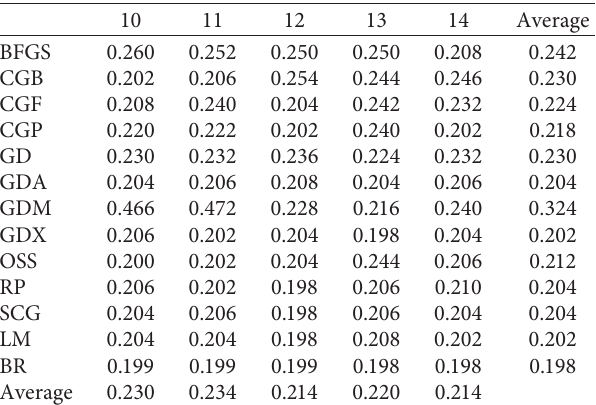
Table 3: Test on the number of neural network hidden layer nodes (best validation performance in terms of MSE).